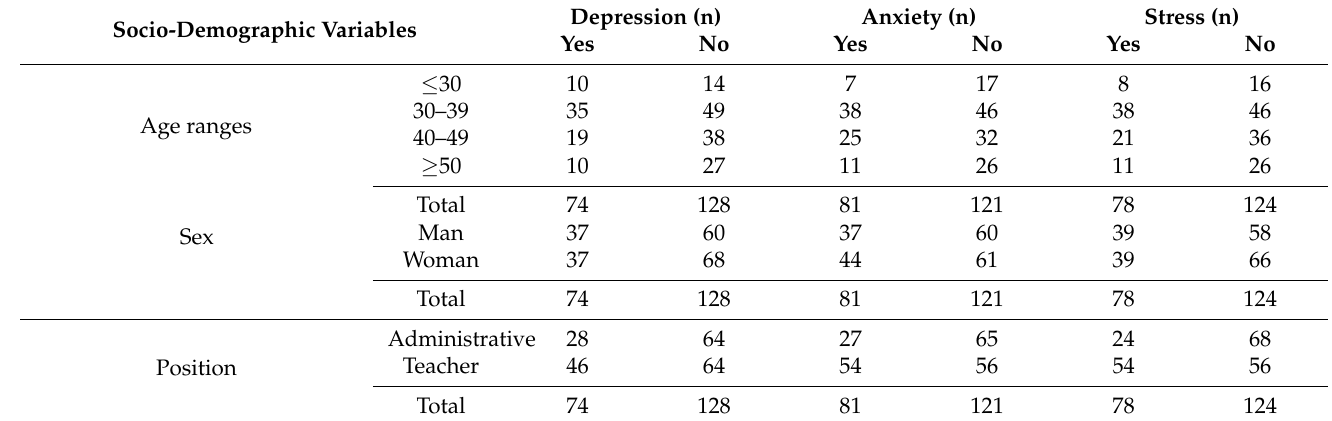
Table 2. Relationship between age, sex, position variables and the presence of